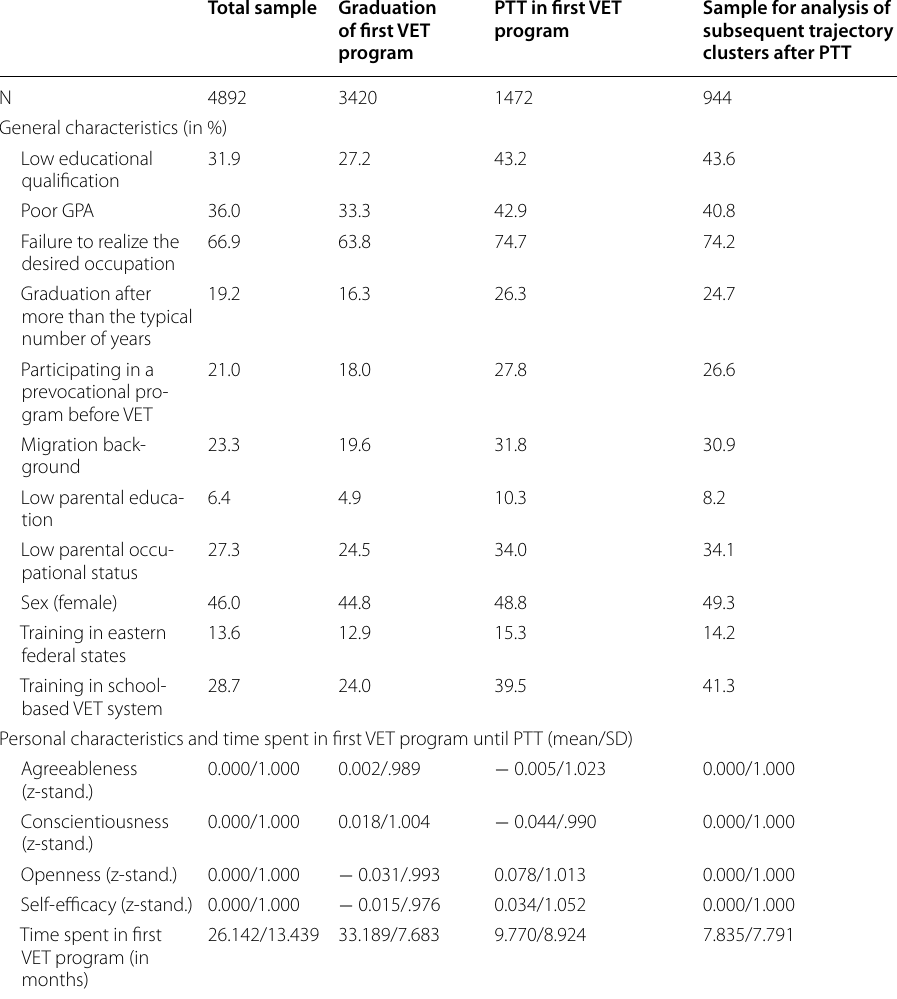
Table 2 Distribution of independent and control